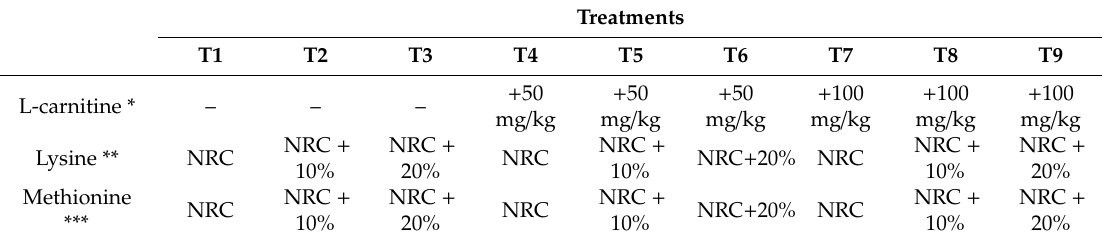
Table 2. Levels of L-carnitine, lysine and methionine of the experimental dietary